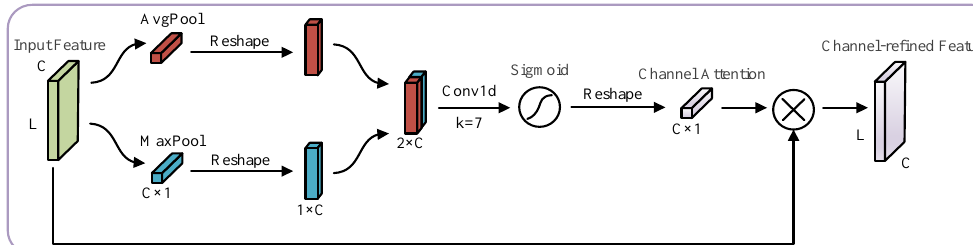
Figure 3. Channel Attention Module in the CBAM. C stands for channel and L stands for length. Inspired by the spatial attention module structure in the CBAM, an improved channel attention mechanism was proposed using a one-dimensional convolution instead of the original shared fully connected layer. The side effects of bottleneck structures were avoided while ensuring cross-channel information interaction and reducing model complexity. The design of the specific improved channel attention module is shown in Figure 4, and the use space attention module in this paper is shown in Figure 5. The improved Channel Attention Module (CAM) was connected in series with the original Spatial Attention Module (SAM) to form the Channel–Spatial Attention Module (CSAM) used in this paper.